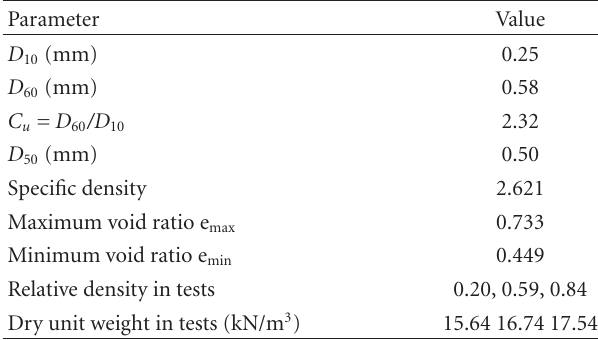
Table 1: Properties of Esbjerg